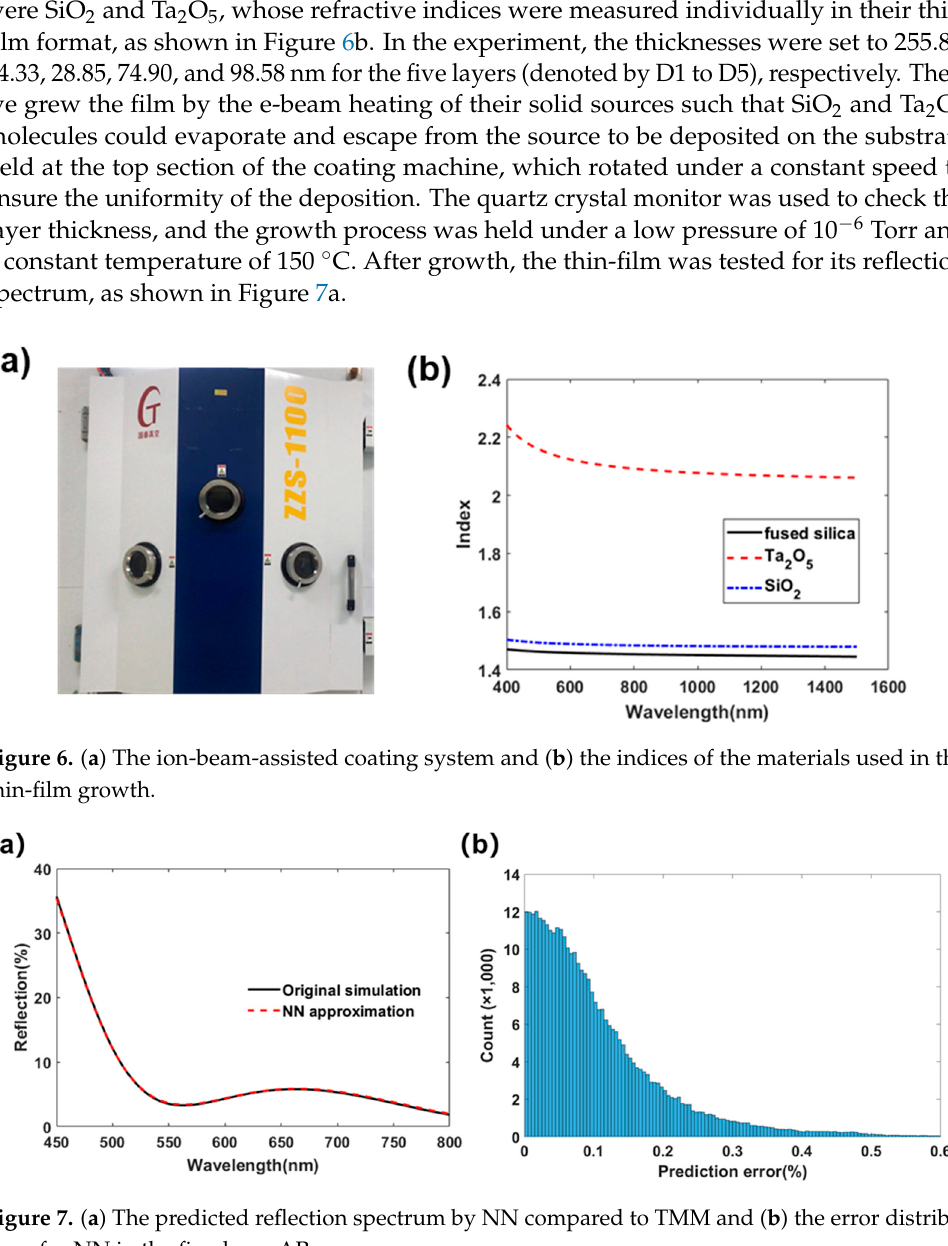
Figure 7. ( a ) The predicted reflection spectrum by NN compared to TMM and ( b ) the error distri- butions for NN in the five-layer AR case.